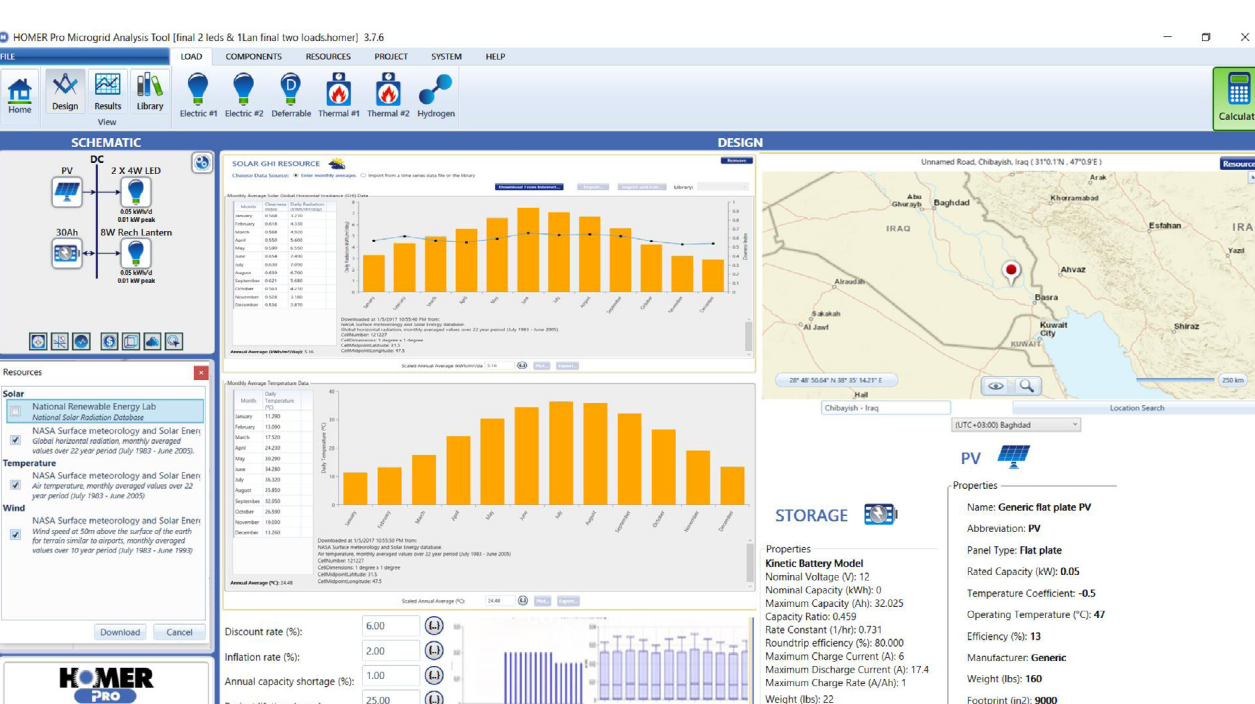
Fig. 4. Screen capture for the data inputs to Homer renewable energy simulation